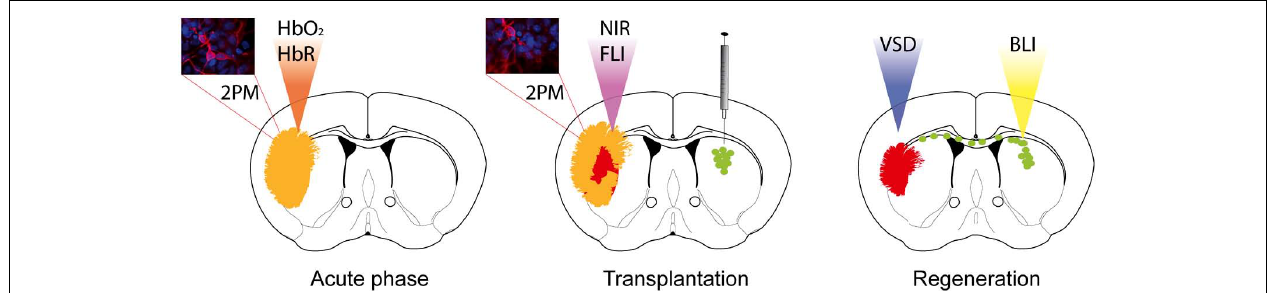
in blood flow. Near-infrared probes have been designed to target, e.g., apoptotic cells or immune cells specifically by fluorescence imaging (FLI). Functional reorganization can be monitored by application of voltage-sensitive dye (VSD) imaging.Transplanted stem cells expressing bioluminescence and fluorescence imaging reporters allow longitudinal monitoring by bioluminescence imaging (BLI) and histological